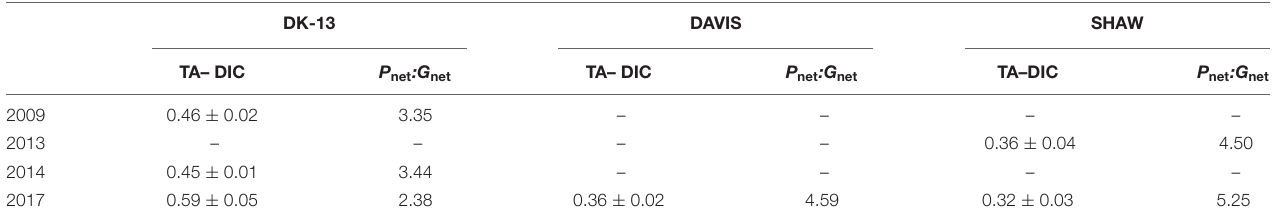
TABLE 2 | Previously reported and calculated slopes ( ± standard deviation) of TA–DIC regression equations and P net : G net